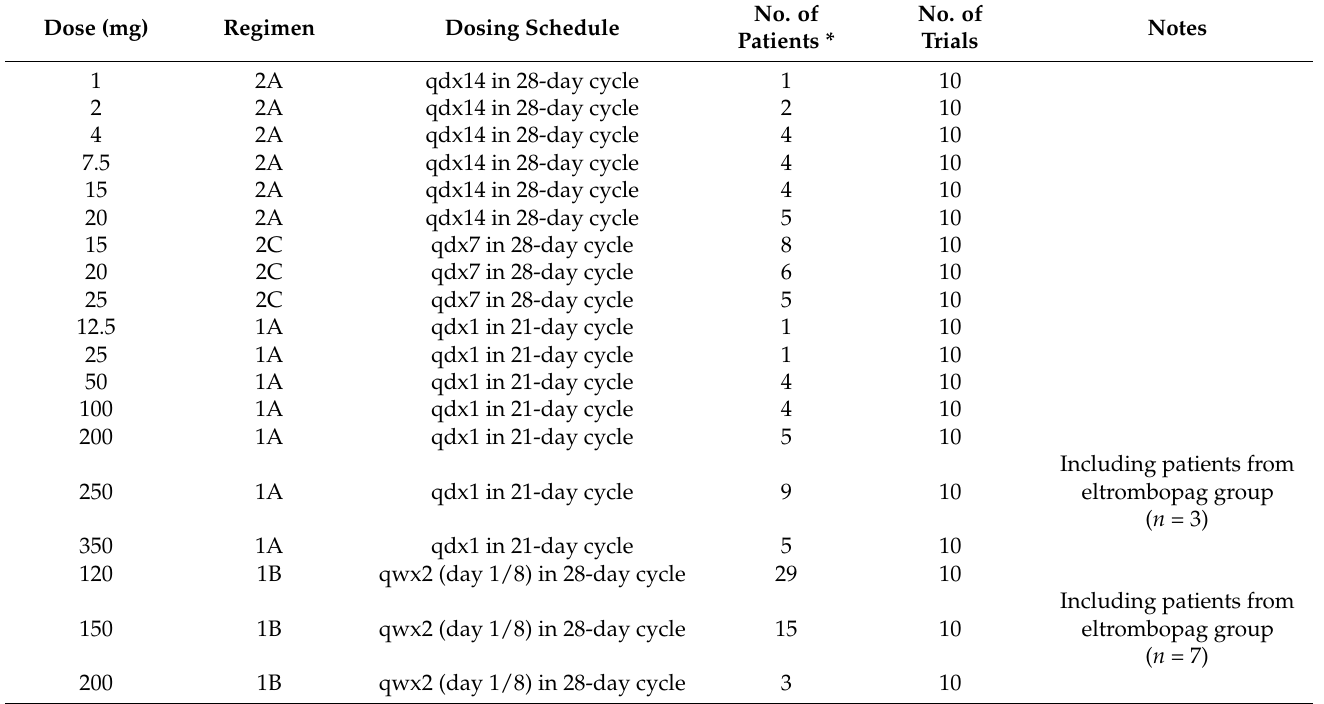
Table S13. Descriptions of the dose levels, dosing schedules, and the number of patients in each resimulated group are shown in Table 7. Table 7. Descriptions of resimulated groups treated with